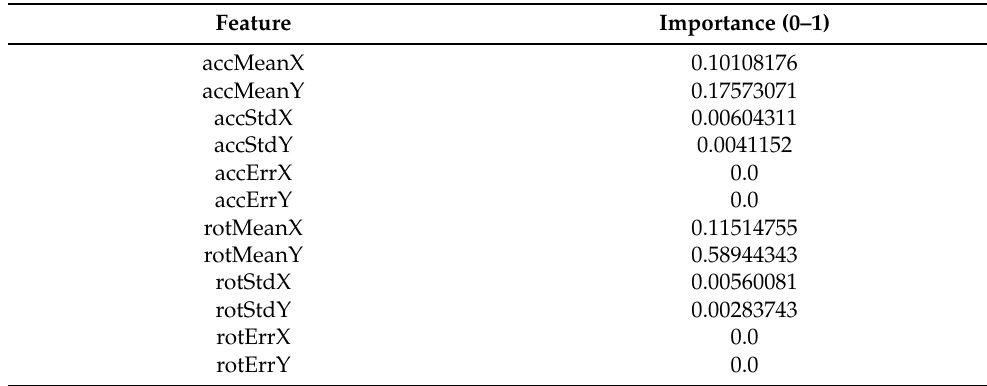
Figure 6. Orientation ML model structure. Table 1. Table of the feature importances.